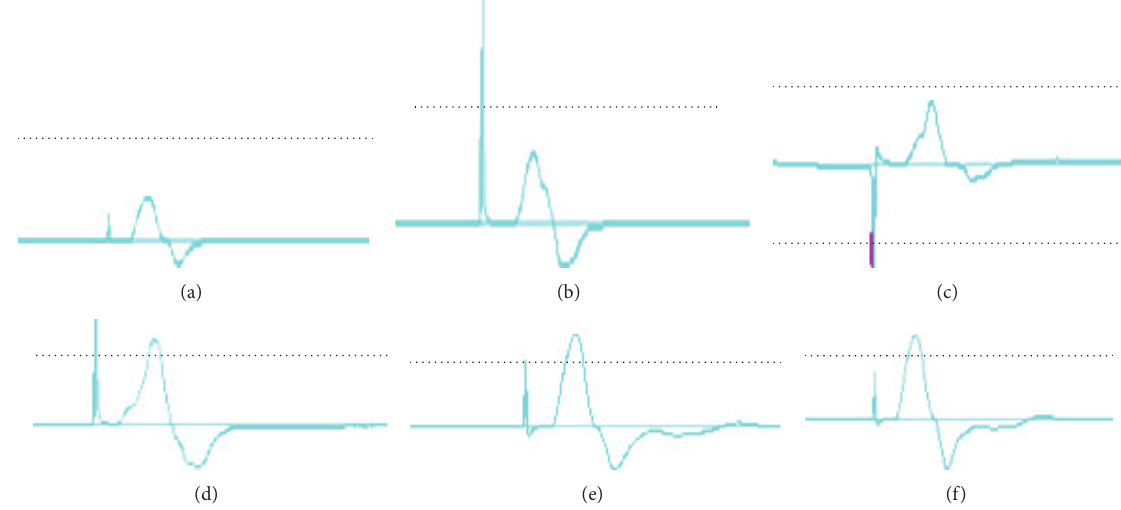
Figure 3: ((a), (b), and (c)) Neural electrophysiology of group A (a), group B (b), and group C (c) at 6 weeks. ((d), (e), and (f)) Neural electrophysiology of group A (d), group B (e), and group C (f) at 12